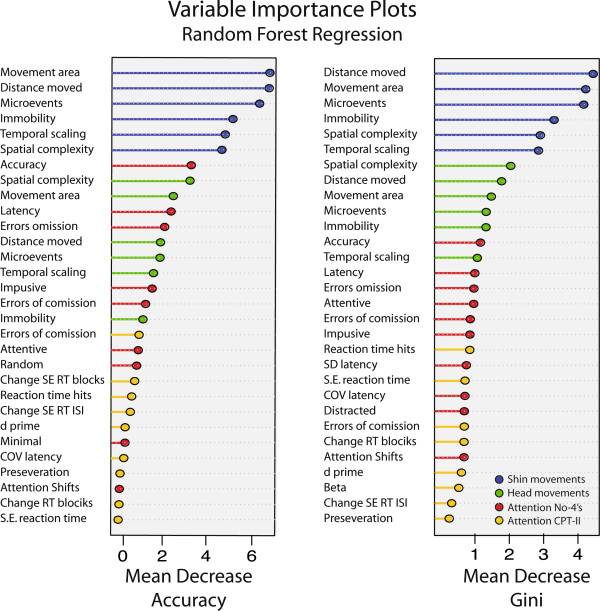
Random forest regression analysis showing the relative importance of activity and attention measures in classifying subjects as ADHD or controls. Variables are rank ordered by importance, which was determined in two ways. The left panel indicates importance by how much the permutation (effective elimination) of a given variable decreases the accuracy of the overall fit. The right panel indicates importance by how much the permutation of a variable attenuates the ability of the specific nodes in the random forest to accurately split the sample. Variables that are associated with the greatest decrease in accuracy or Gini coefficient following permutation are the most important.